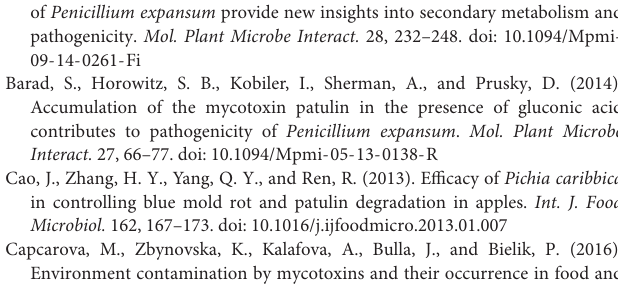
FIGURE S1 | Correlation between Penicillium expansum biomass (expressed as ng of DNA/ µ g of decayed tissue) and patulin content ( µ g/g of decayed tissue) in artificially infected apples treated with the following microorganisms: PePY (A) ; RkLS11 + PePY (B) ; Rm3617 + PePY (C) ; PeFS7 (D) ; RkLS11 + PeFS7 (E) ; Rm3617 + PeFS7 (F) . PePY, Penicillium expansum strain PY; PeFS7, P. expansum strain FS7; RkLS11, Rhodotorula kratochvilovae strain LS11; Rm3617, R. mucilaginosa strain 3617. FIGURE S2 | Correlation between lesion diameter (mm) and P. expansum biomass (expressed as ng of DNA/ µ g of decayed tissue) in artificially infected apples treated with the following microorganisms: PePY (A) ; RkLS11 + PePY (B) ; Rm3617 + PePY (C) ; PeFS7 (D) ; RkLS11 + PeFS7 (E) ; Rm3617 + PeFS7 (F) . PePY, Penicillium expansum strain PY; PeFS7, P. expansum strain FS7; RkLS11, Rhodotorula kratochvilovae strain LS11; Rm3617, R. mucilaginosa strain 3617. FIGURE S3 | Correlation between patulin content ( µ g/g of decayed apple tissue) and lesion diameter (mm) in artificially infected apples inoculated treated with the following microorganisms: PePY (A) ; RkLS11 + PePY (B) ; Rm3617 + PePY (C) ; PeFS7 (D) ; RkLS11 + PeFS7 (E) ; Rm3617 + PeFS7 (F) . PePY, Penicillium expansum strain PY; PeFS7, P. expansum strain FS7; RkLS11, Rhodotorula kratochvilovae strain LS11; Rm3617, R. mucilaginosa strain 3617. FIGURE S4 | Time course of disease incidence (% of infected wounds) in artificially inoculated apples stored at 20 ◦ C. Bars represent the mean values from two experiments ± standard deviations. Bars with ∗ indicate significant difference ( P < 0.05). PePY, Penicillium expansum strain PY; PeFS7, P. expansum strain FS7. FIGURE S5 | Time course of lesion diameter (mm) in artificially inoculated apples stored at 20 ◦ C. Bars represent the mean values from two experiments ± standard deviations. Bars with ∗ indicate significant difference ( P < 0.05). PePY, Penicillium expansum strain PY; PeFS7, P. expansum strain FS7. FIGURE S6 | Time course of patulin contamination ( µ g/g of decayed apple tissue) in apples artificially infected by PePY and PeFS7 during storage at 20 ◦ C. Bars represent the mean values from two experiments ± standard deviations. Bars with ∗ indicate significant difference ( P < 0.05). PePY, Penicillium expansum strain PY; PeFS7, P. expansum strain FS7. FIGURE S7 | Time course of P. expansum biomass development (ng DNA/ µ g of decayed apple tissue) in apples artificially infected by PePY and PeFS7 during storage at 20 ◦ C. Bars represent the mean values from two experiments ± standard deviations. Bars with ∗ indicate signficant difference ( P < 0.05). PePY, Penicillium expansum strain PY; PeFS7, P. expansum strain FS7. FIGURE S8 | Time course of specific mycotoxigenic activity (ng patulin/ µ g of fungal DNA) of strains PY and FS7 of Penicillium expansum in infected apples stored at 20 ◦ C. Bars represent the mean values from two experiments ± standard deviations. Bars with ∗ indicate significant difference ( P < 0.05). PePY, Penicillium expansum strain PY; PeFS7, P. expansum strain